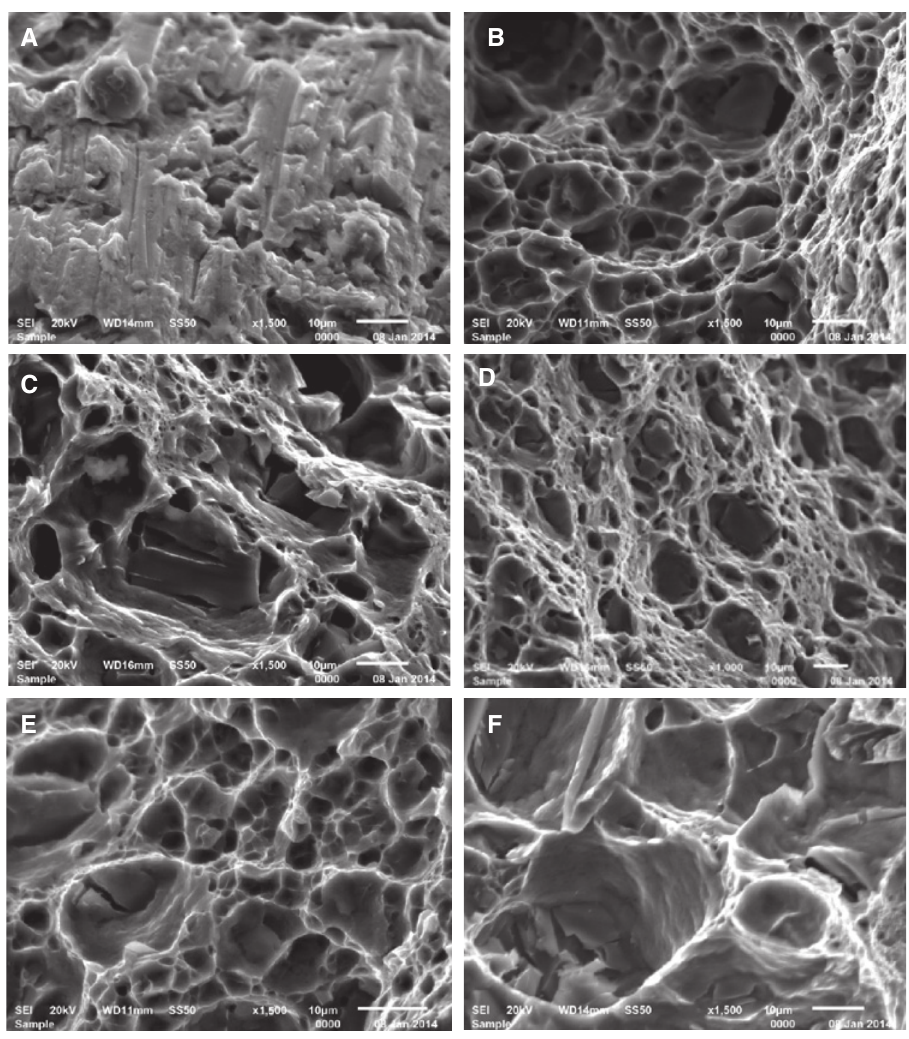
Figure 6: Effect of TVR on fracture morphology.